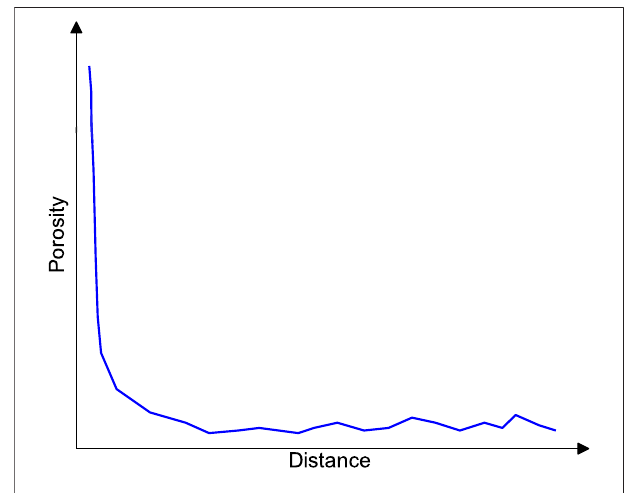
FIGURE1| Porositydistribution insteel-concreteinterfacialzone(Horne et al.,